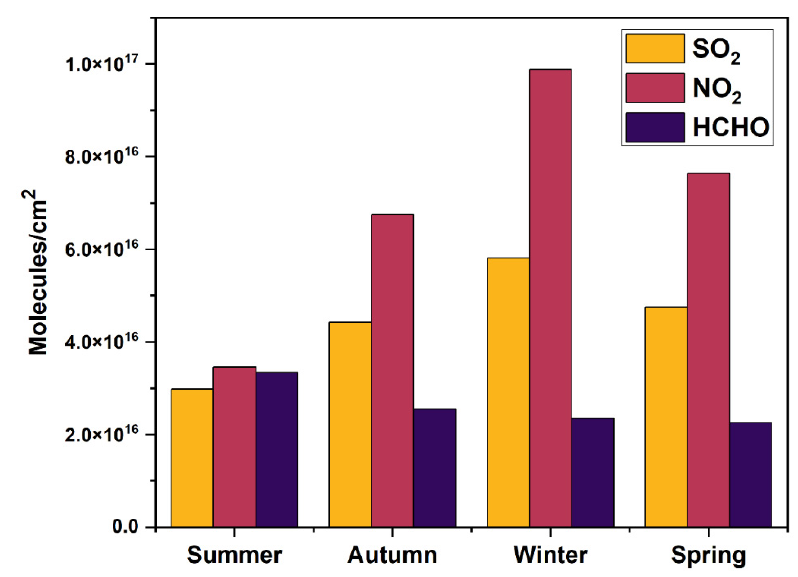
Figure 3. Seasonal variation in SO 2 , HCHO, and NO 2 over